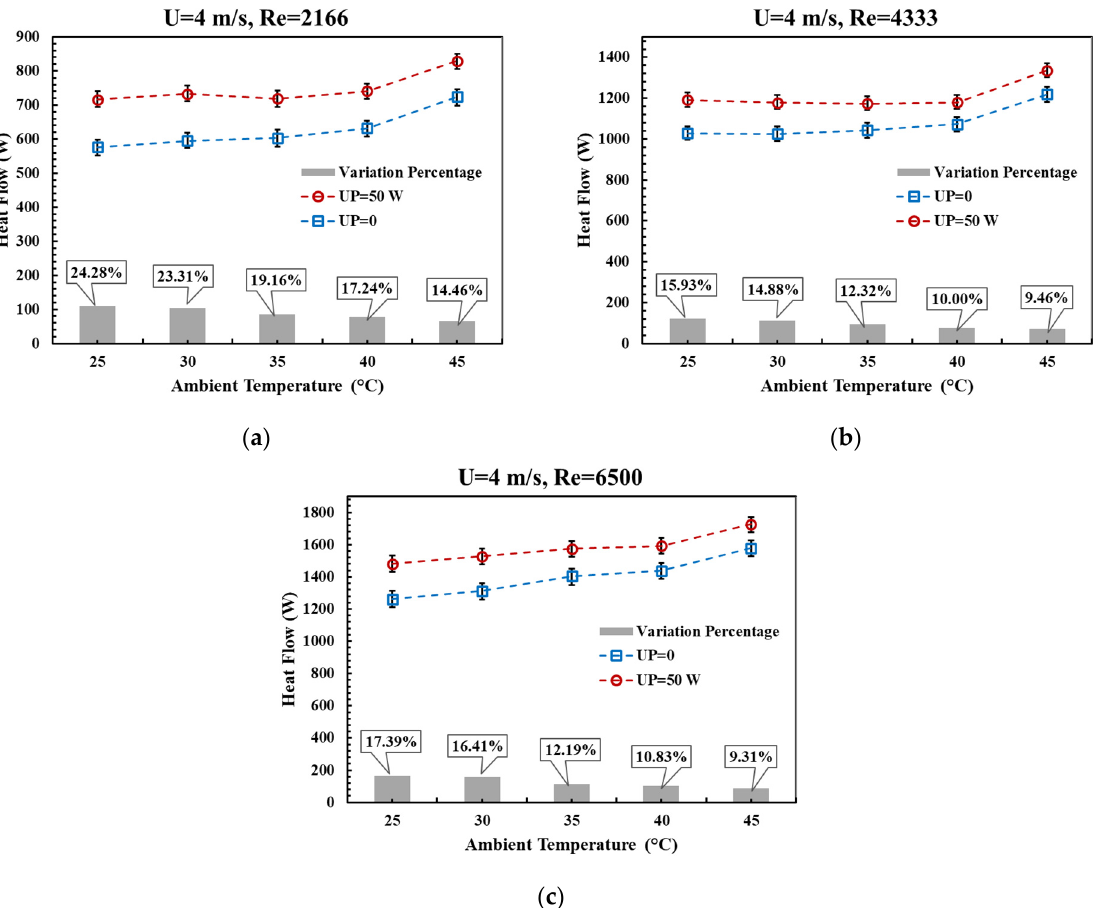
Figure 10. The variations of heat flow against ambient temperature at 𝑈 = (4 m/s) and Reynolds number of ( a ) Re = 2166, ( b ) Re = 4333, ( c ) Re = 6500. The results are presented in no vibration state (UP = 0) and in the presence of vibration with ultrasonic power of 50 Watts (UP = 50 (W)).